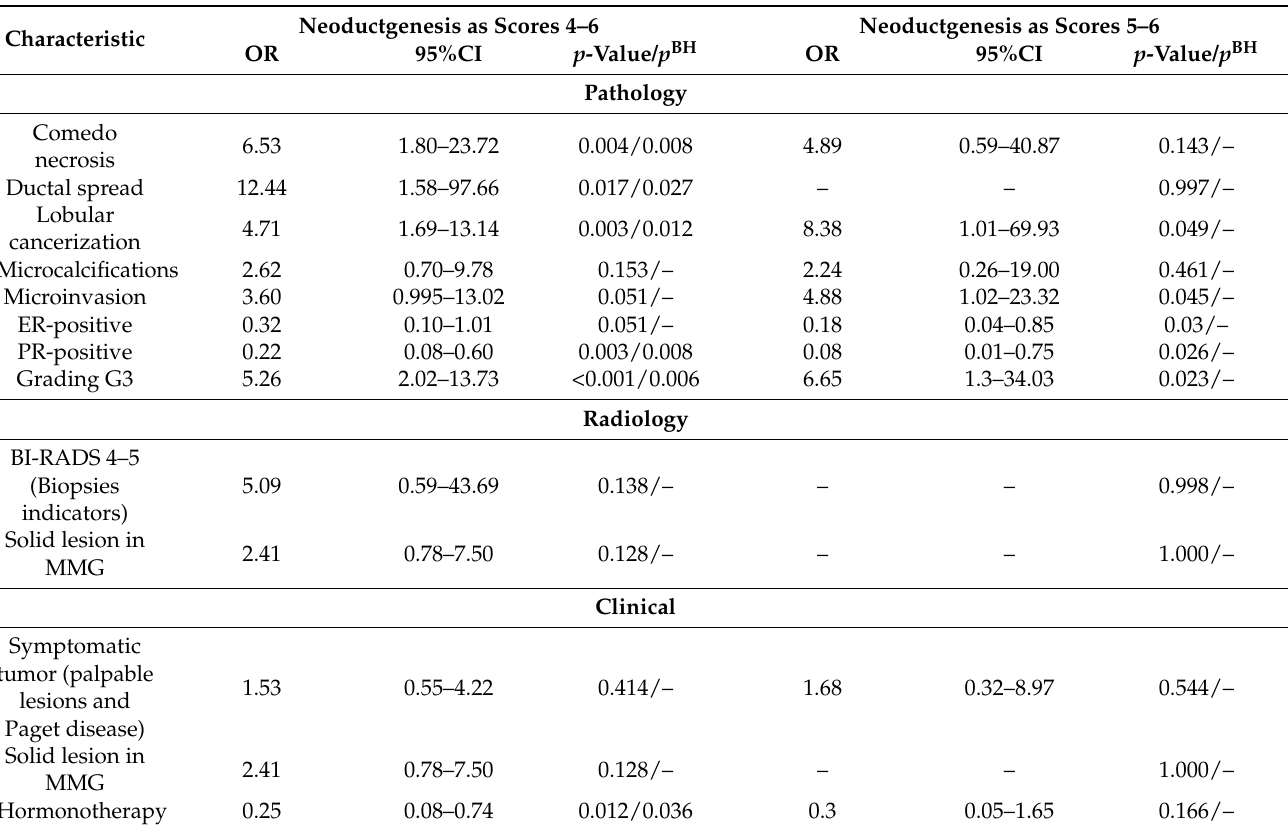
Table 6. Univariate logistic regression model that predicts the OR of distinct histological, radiological and clinical characteristics of DCIS depending on the presence of neoductgenesis as scores 4–6 and neoductgenesis as scores